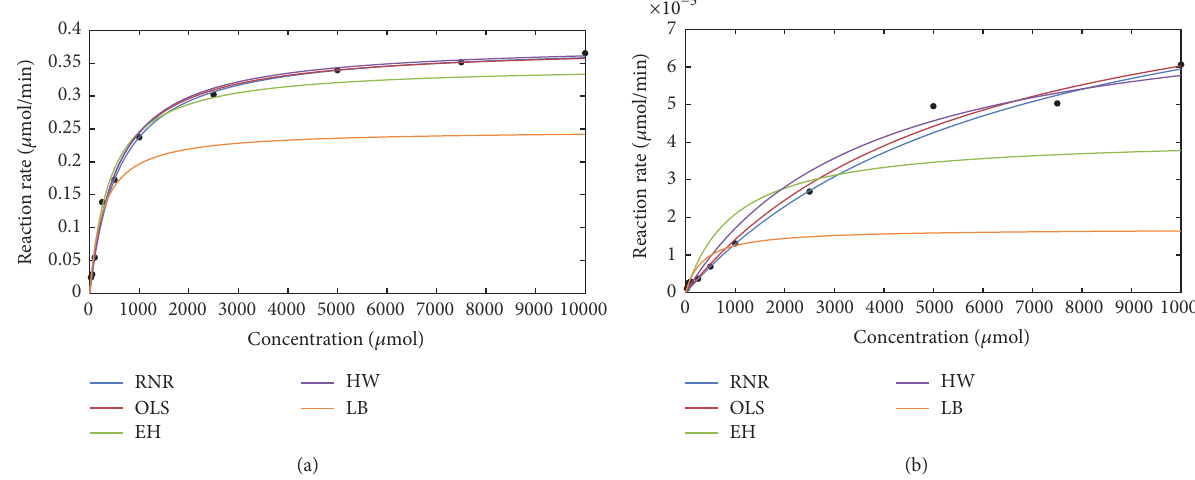
Figure 7: Curves fitted using different fitting techniques for tyrosinase extracted from Agaricus bisporus (a) and Pleurotus ostreatus (b) mushrooms.